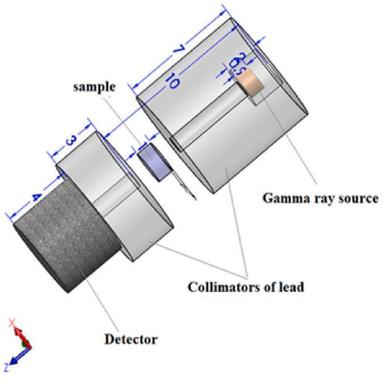
The MCNP's input file.